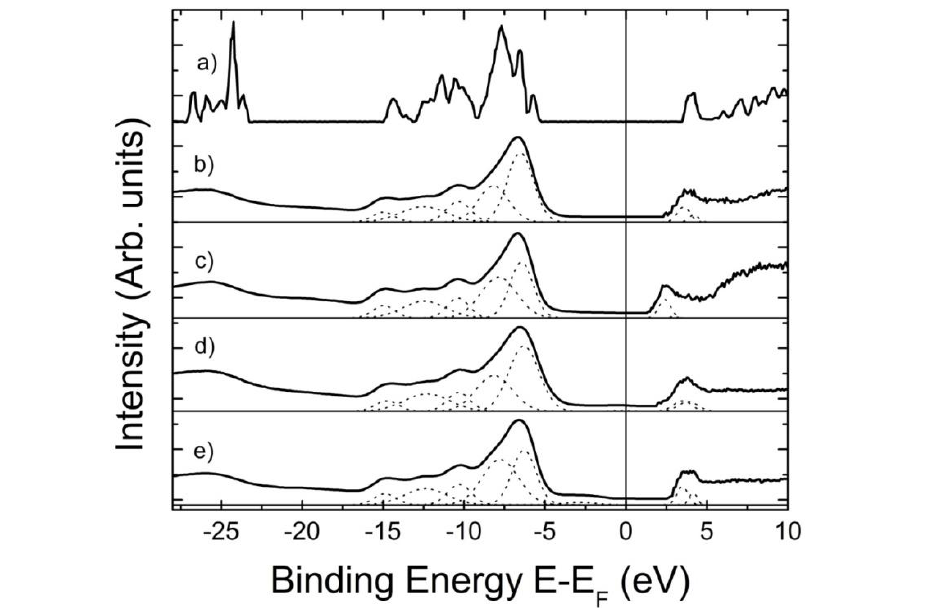
Figure 1. A comparison of the combined experimental photoemission (left) and inverse photoemission (right) data, in E-E theoretical density of the bulk band states of crystalline Li LDA PW1PW is adapted from Islam et al . [14]. The combined experimental photoemission (left) and inverse photoemission (right) data for Li in-plane component of the incident light E for photoemission oriented along [011]; ( b ) and [010]; ( c ) are shown along with the data for Li component of the incident light E for photoemission oriented along [001]; ( d ) and [110]; ( e ) For the photoemission, the photon energy is 56 eV and the synchrotron light is incident at 45 degrees with respect to sample normal. The electrons were either collected along the surface normal (photoemission) or incident along the surface normal (inverse photoemission). The sample temperature for these measurements was 623 ± 5 K, to reduce surface charging. Adapted from